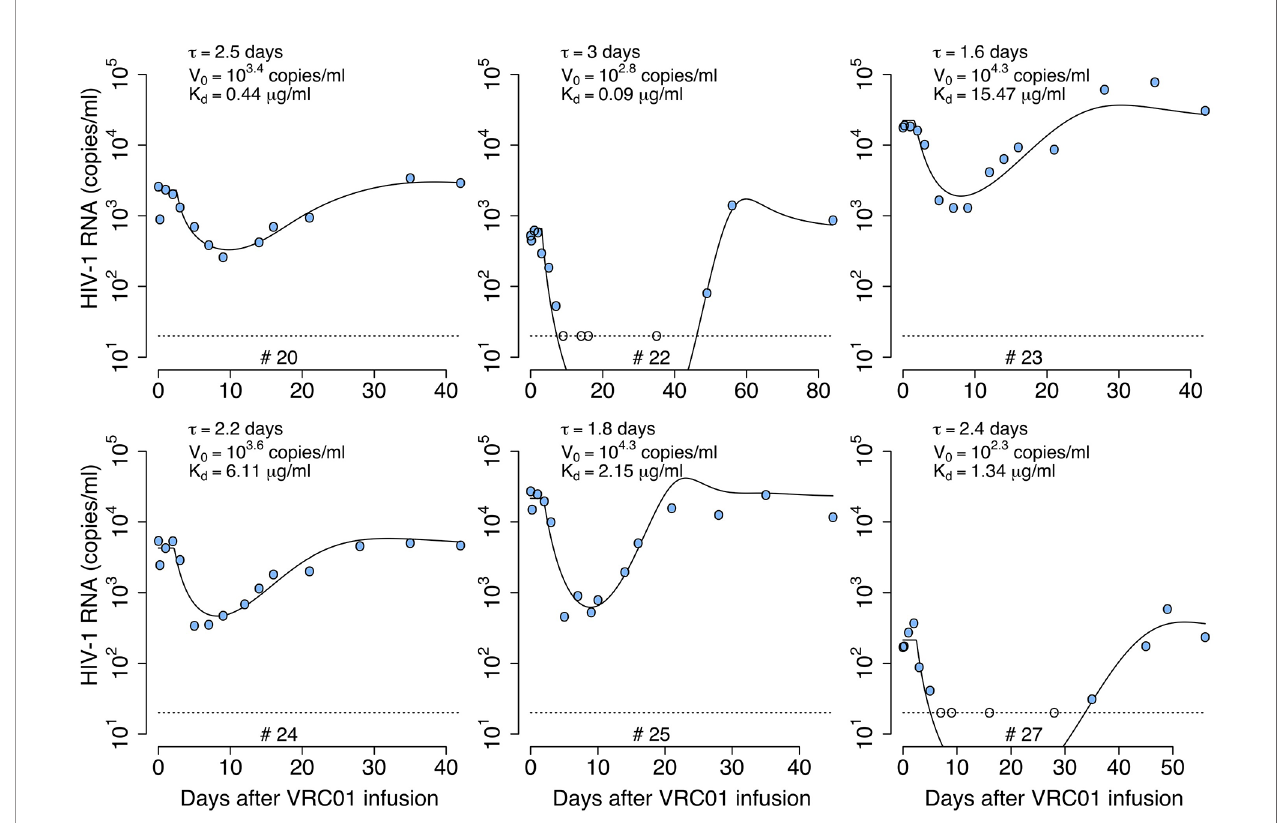
FIGURE 4 | Best- fi ts of the delayed neutralization model, equation (12), to viral load data from participants receiving a single infusion of VRC01. Blue- fi lled and un fi lled circles are the HIV-RNA over and below the limit of detection, respectively. Solid black lines are the best- fi t of the model in equation (12) to the data. Fixed parameter values are described in Table 1 . See all parameters estimates in Table S2 . Other parameters and initial values were derived by assuming the system was in steady state before VRC01